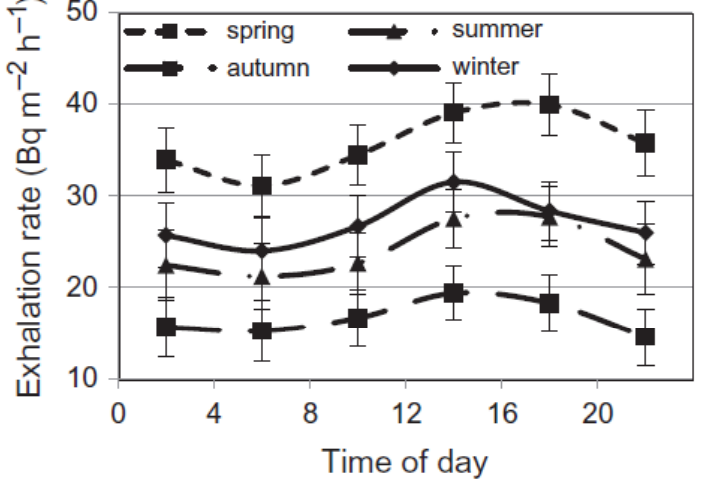
Figure 4. Diurnal variation of radon flux for different seasons (from [136]).